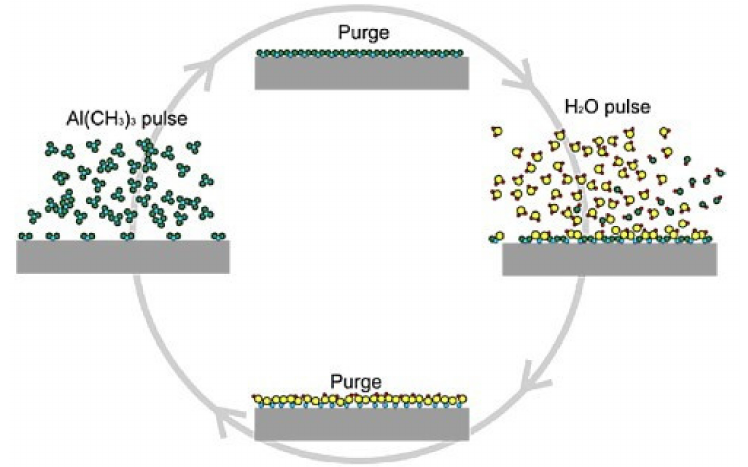
Figure 8. Schematics of an ALD growth cycle. Reproduced with permission from [86]. Elsevier,